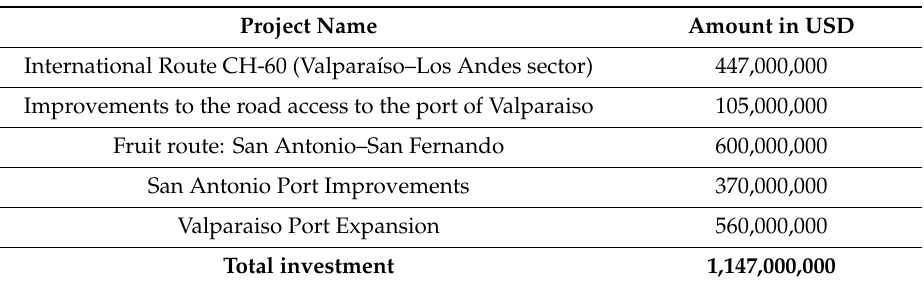
Table 5. National projects of the Mercosur-Chile axis linked to export